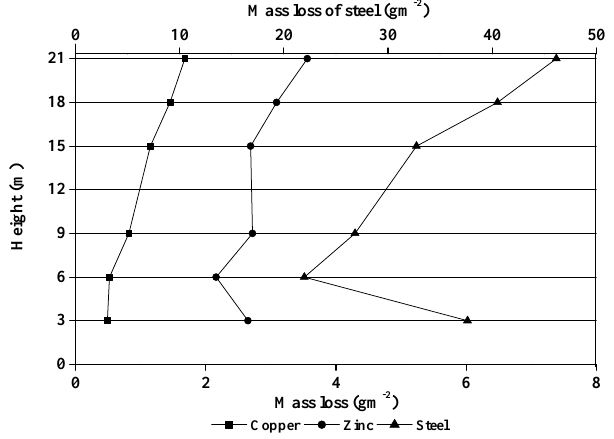
Fig. 4. Mass loss of the specimens exposed for one year at specific levels (sheltered).